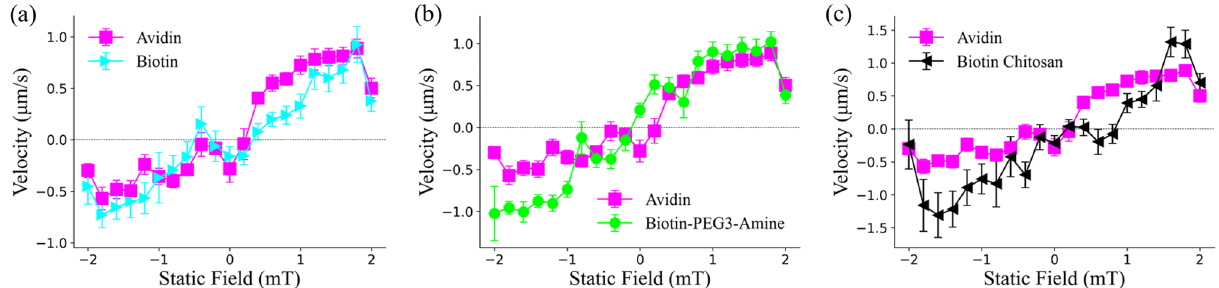
Figure 6. Static magnetic field sweeps for avidin, biotin, biotin chitosan, and Biotin-PEG3-amine coated microparticles. Static field was swept from − 2 to 2 mT at a 0.2 mT incrementation. Four avidin particles, five biotin particles, four chitosan particles, and four Biotin-PEG3-amine particles were used to produce the results in ( a – c ). At least three independent trials were performed per particle. Black horizontal line represents the x -intercept. Lines between points were added for visualization purposes and do not represent